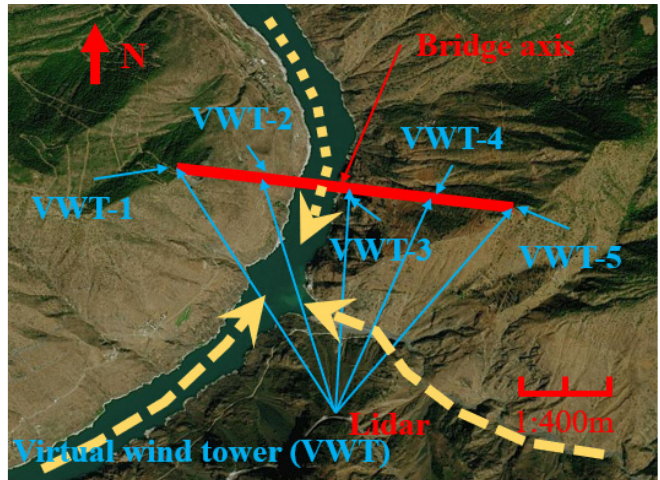
Figure 2. Terrain features and bridge.